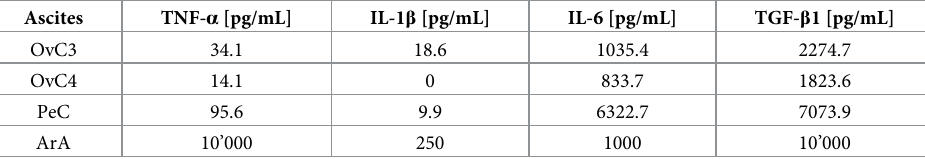
Table 1. Cytokine concentration of patient-derived (OvC3, OvC4, PeC) and artificial ascites